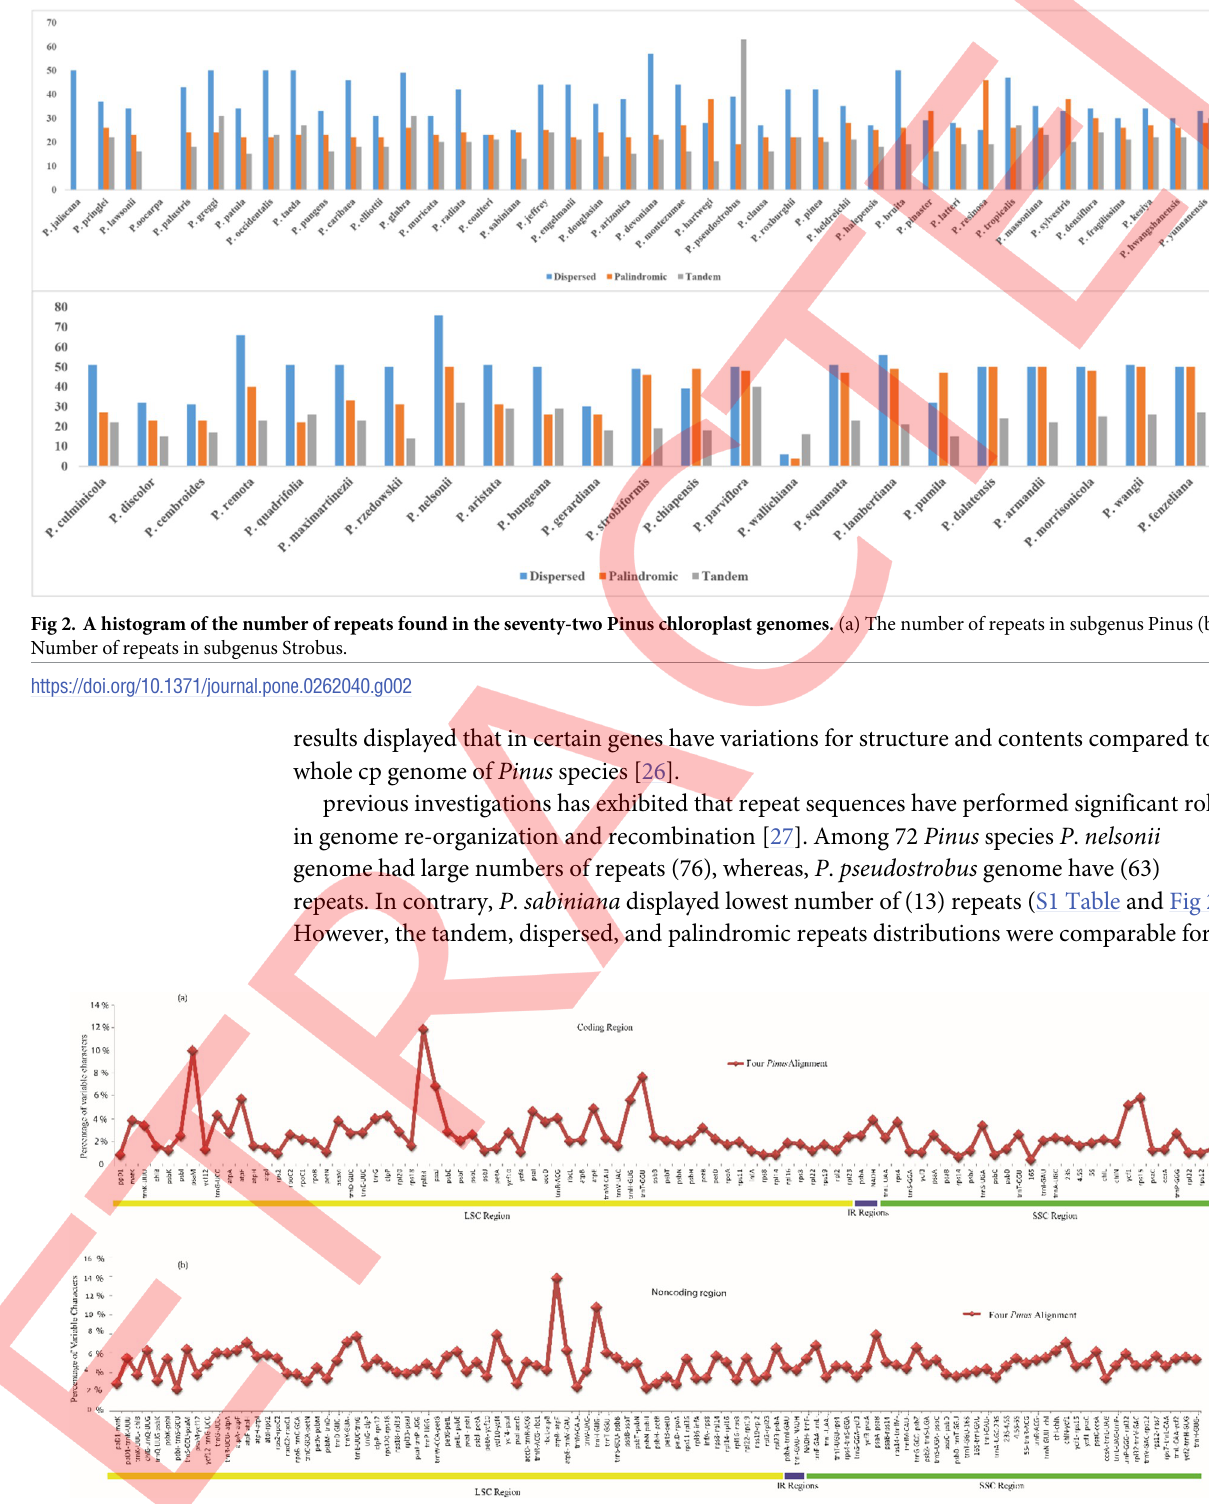
Fig 3. Variable characters percentage in homologous regions of Seventy-two Pinus species of chloroplast genome (a) Coding region (b) Non coding region. The homologous regions are oriented according to their locations in the chloroplast genome.